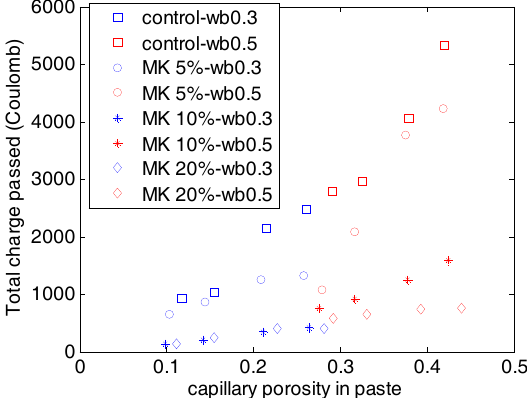
Figure 7. Chloride penetrability vs. capillary porosity.